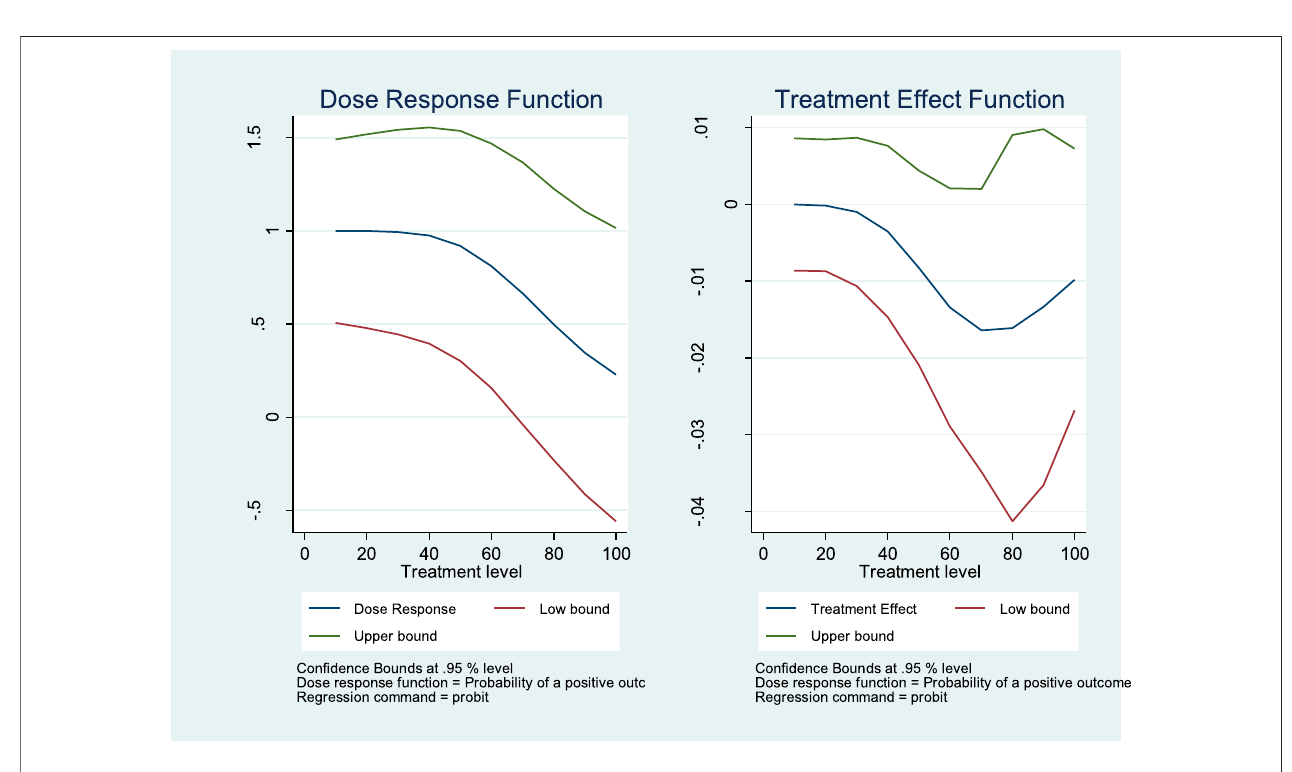
FIGURE 2 | Does-response and treatment effect of EV purchase